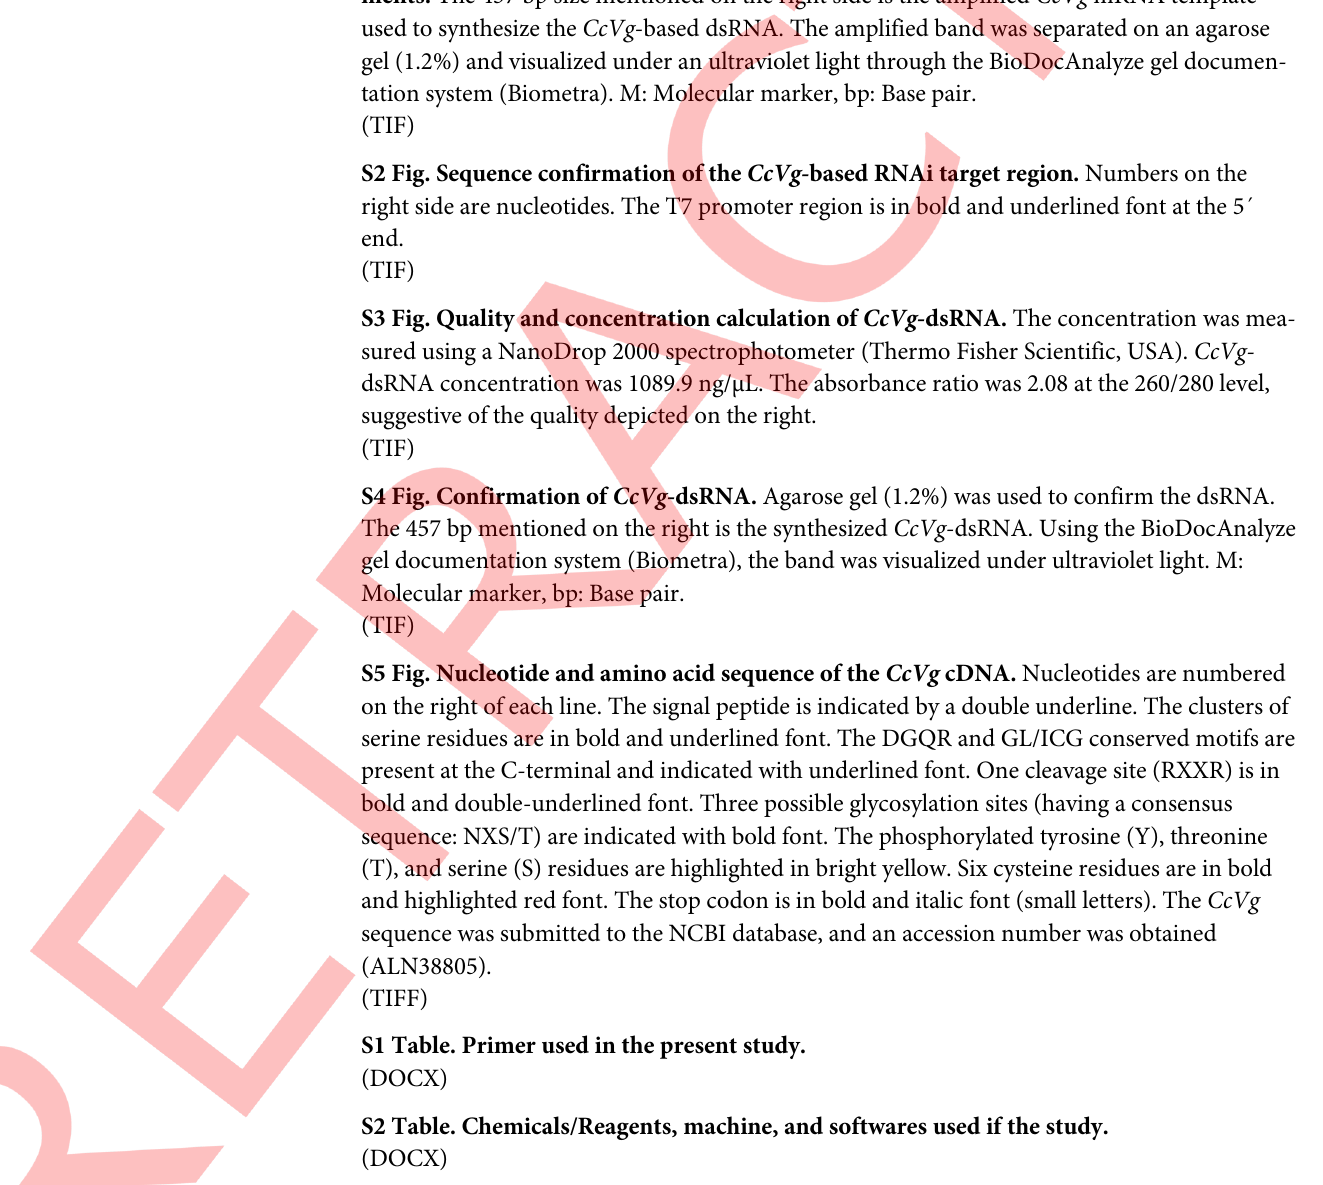
S2 Table. Chemicals/Reagents, machine, and softwares used if the